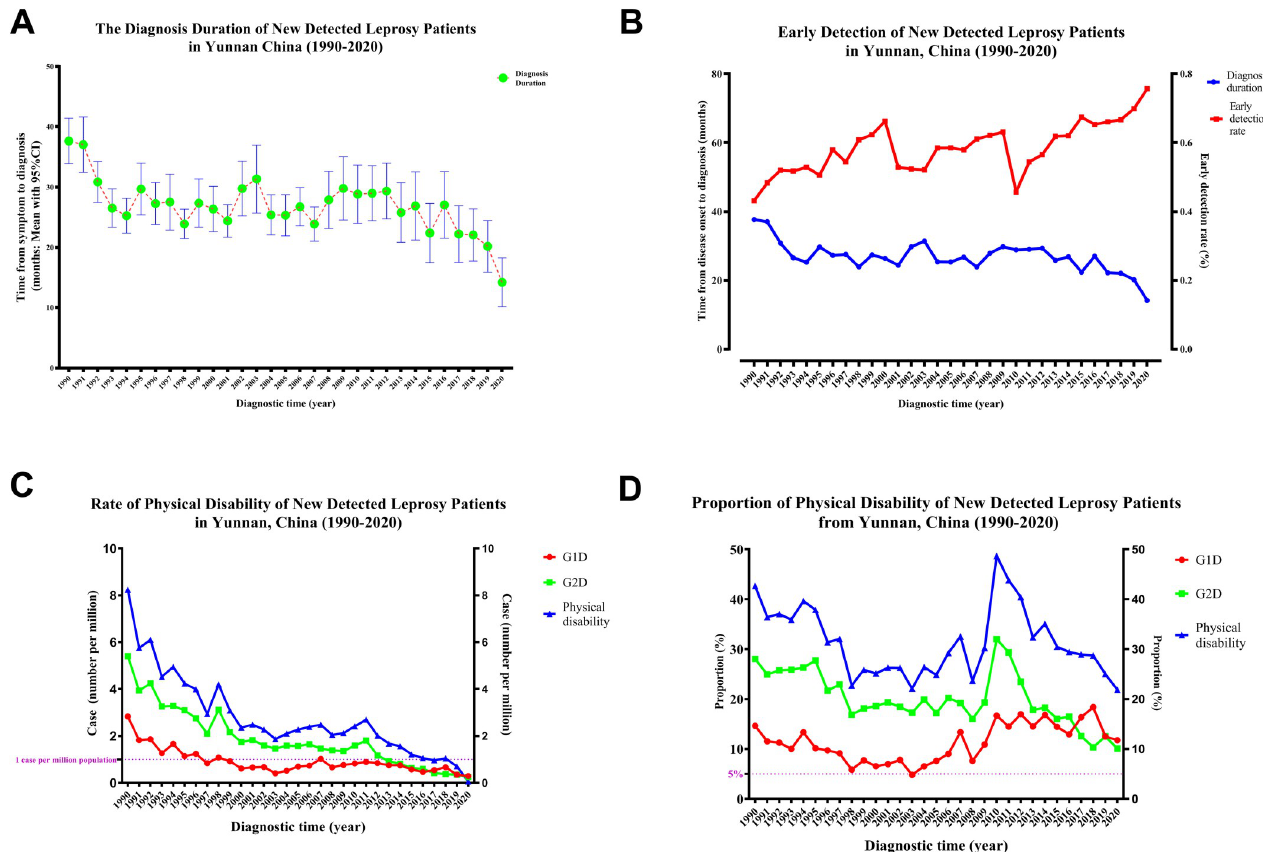
Fig 1. Diagnostic Durations and WHO Leprosy Indicators of Physical Disability in Yunnan, China, 1990–2020.